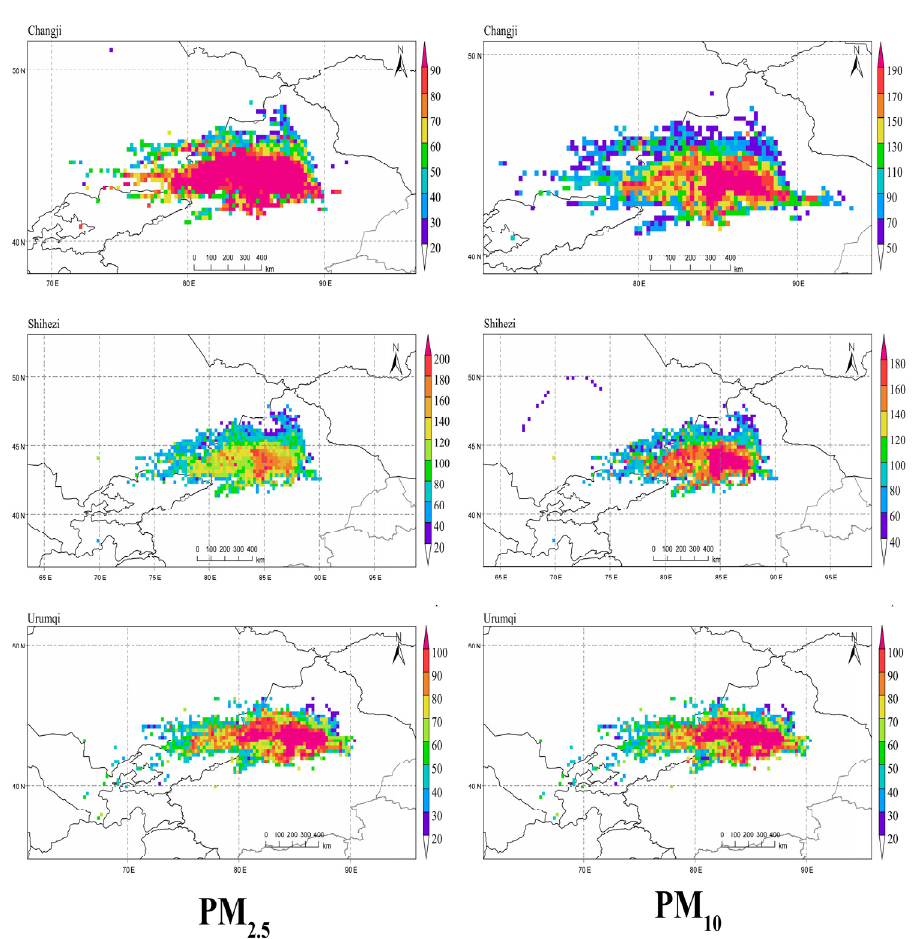
Figure 7. CWT distribution of winter particulate matter in the Wu-Chang-Shi urban. ( μ g m − 3 ). The high-value area (WCWT > 80 μ g m − 3 ) of the potential contributing source area of PM 2.5 in winter in Changji is much more widely distributed than PM 10 , mainly in the local and surrounding areas of Changji, such as Urumqi, Turpan, Shihezi, Kuitun, Ili Kazakh Autonomous Prefecture, and northern Aksu region, with some scattered distribution in southeastern Kazakhstan, northeastern Kyrgyzstan, eastern Uzbekistan, Karamay City and the southern part of Tacheng region also have some sporadic distribution. Compared with PM 2.5 , the high WCWT of PM 10 (WCWT > 170 μ g m − 3 ) is mainly scattered in the areas around Changji city and the central and western parts of Ili Kazakh Autonomous Prefecture. This is related to the winter heating and the intensity of air pollutant emissions in the region. In addition, cold air is frequently active in the west, northwest, and southwest